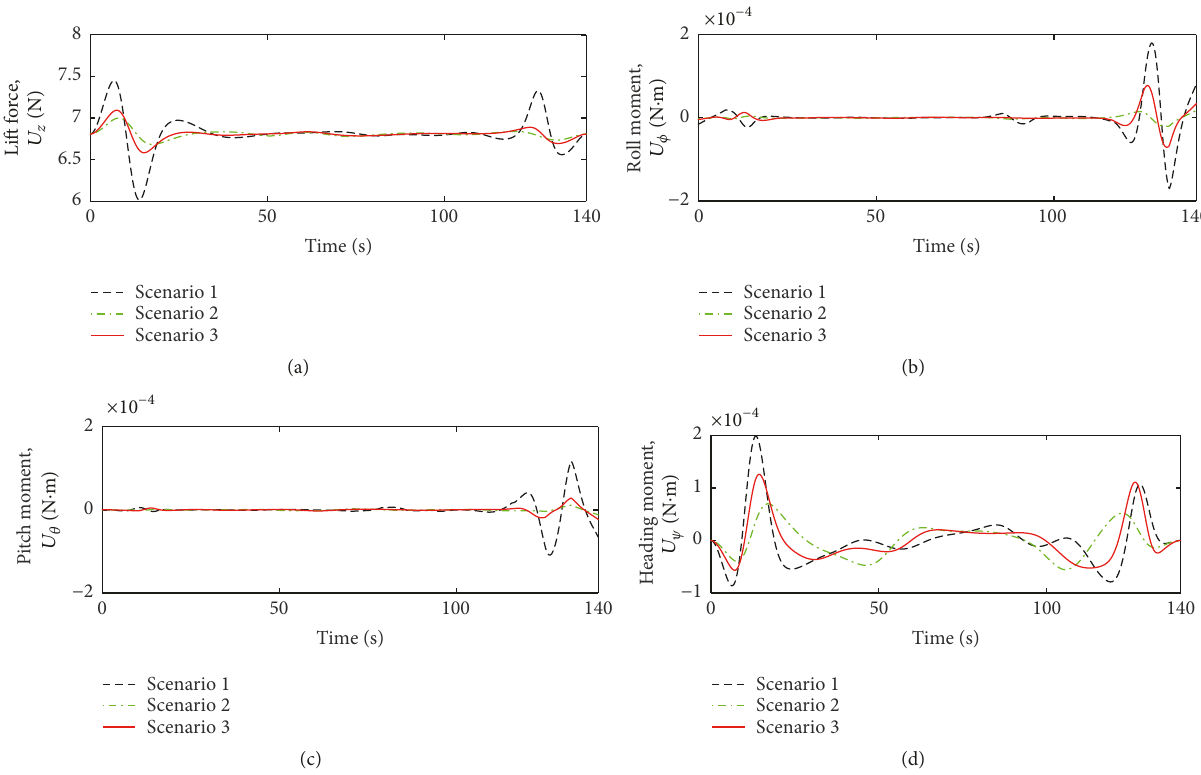
Figure 10: Induced efforts: (a) lift force and aerodynamical (b) roll and (c) pitch and (d) heading moments, respectively.